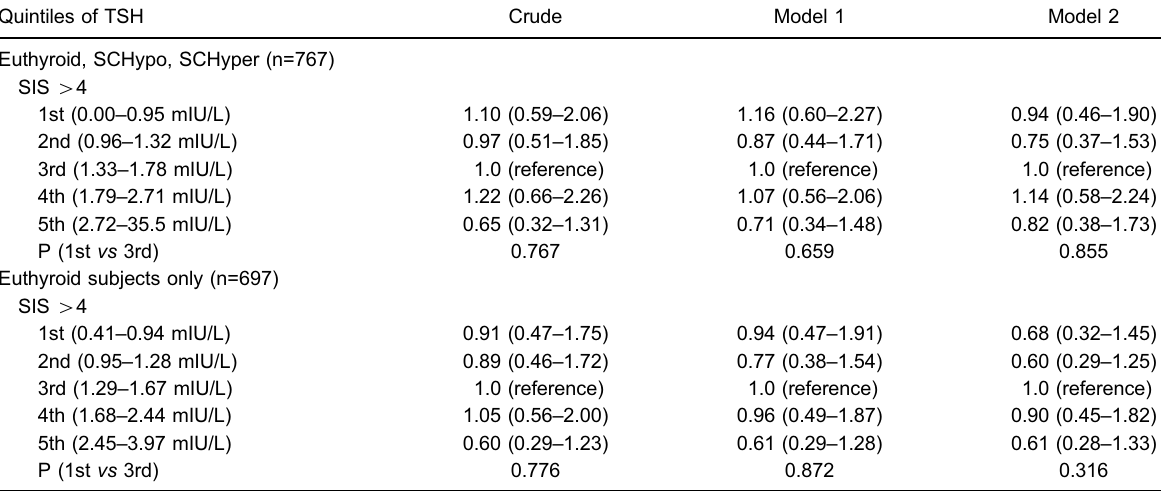
Table 3. Odds ratio and 95% con fi dence interval for associations of segment involvement score (SIS) 4 4 and quintiles of thyrotropin (TSH) levels. Quintiles of TSH